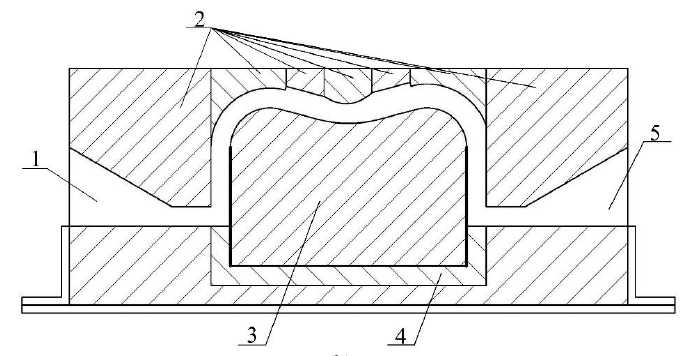
Figure 19. Experimental platform: ( a ) Experiment platform entity: 1, pump; 2, flowmeter; 3, flume; 4,